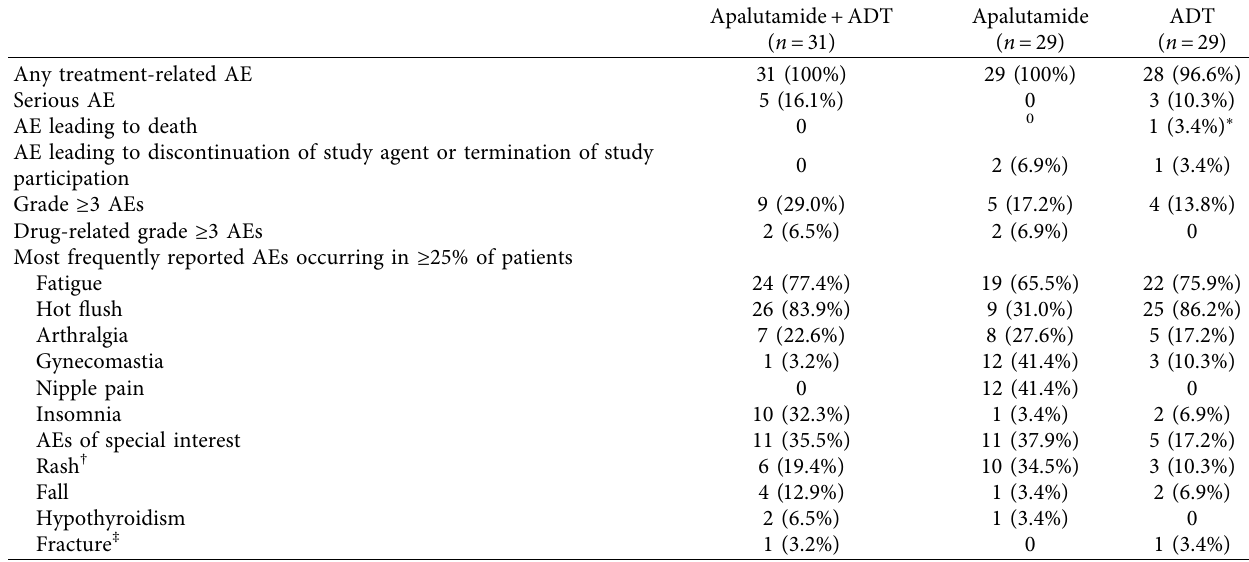
Table 5: Summary of treatment-emergent adverse events in the safety